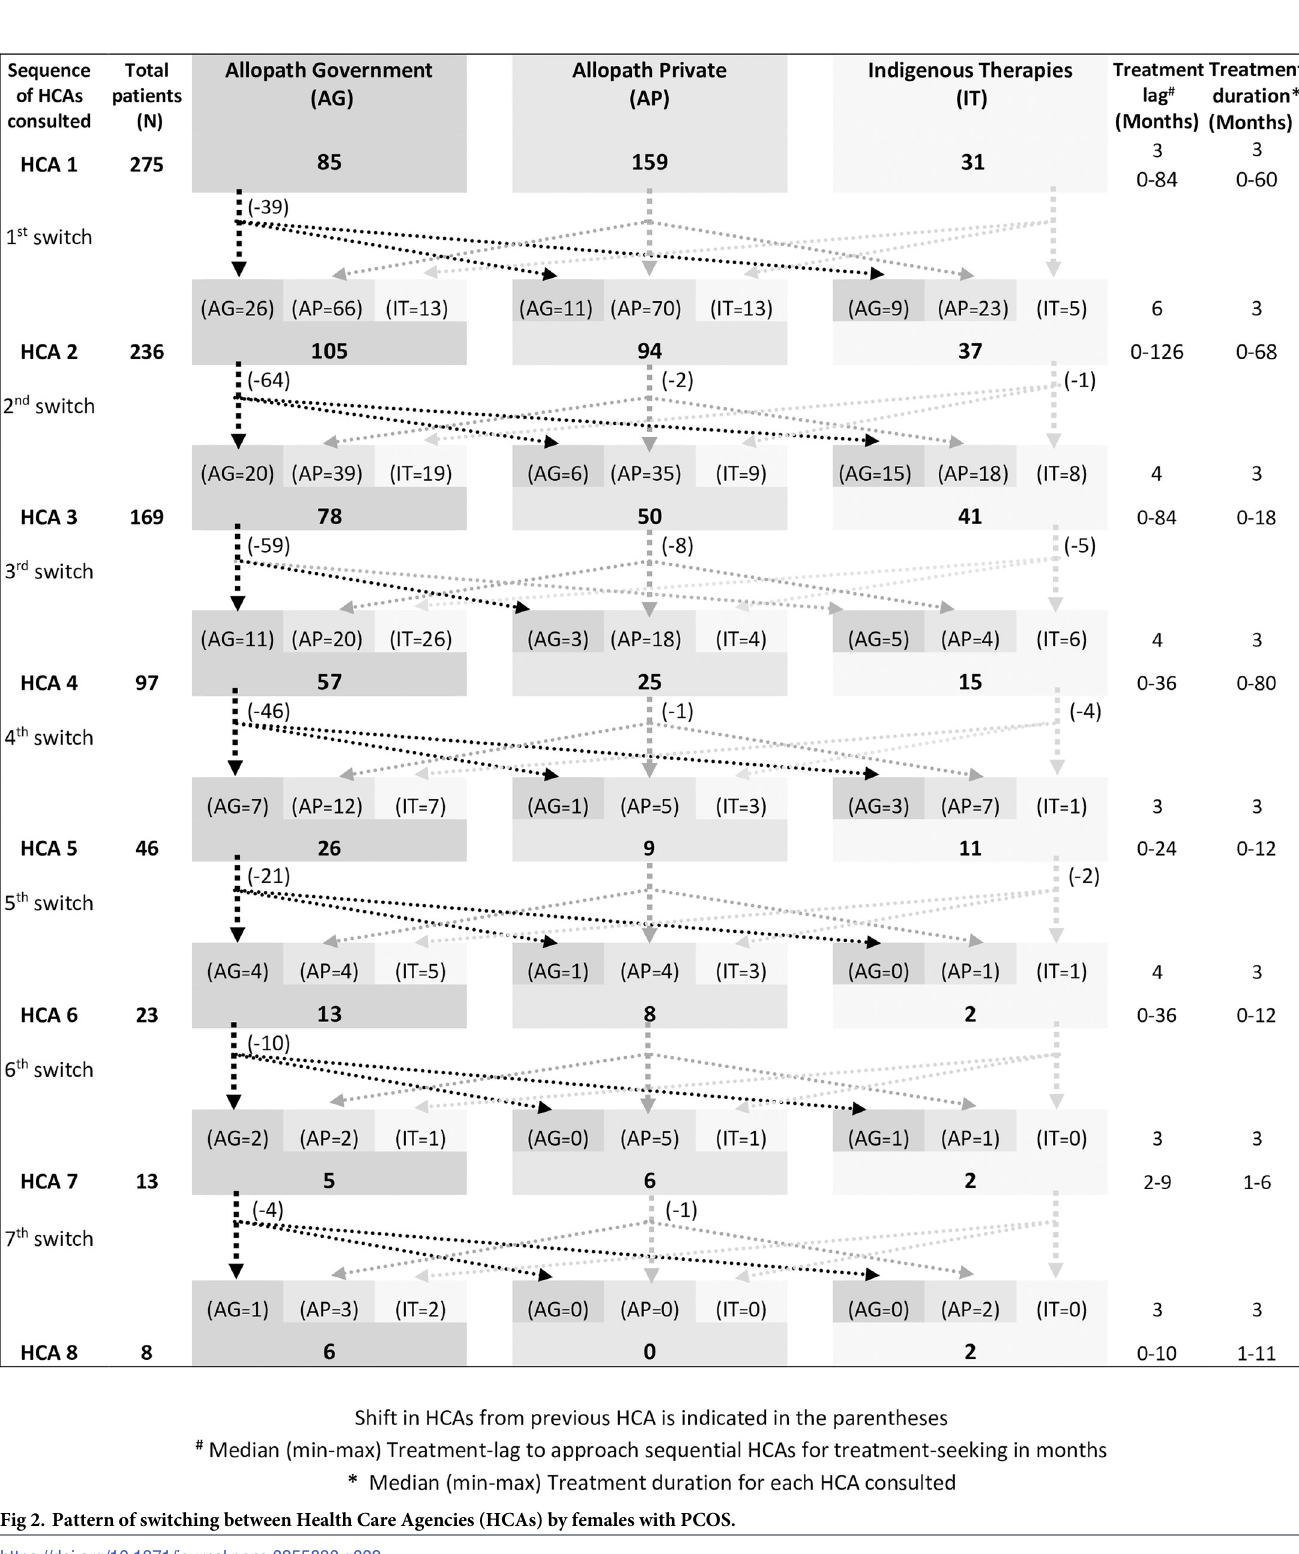
PLOS ONE | https://doi.org/10.1371/journal.pone.0255830 August 9,